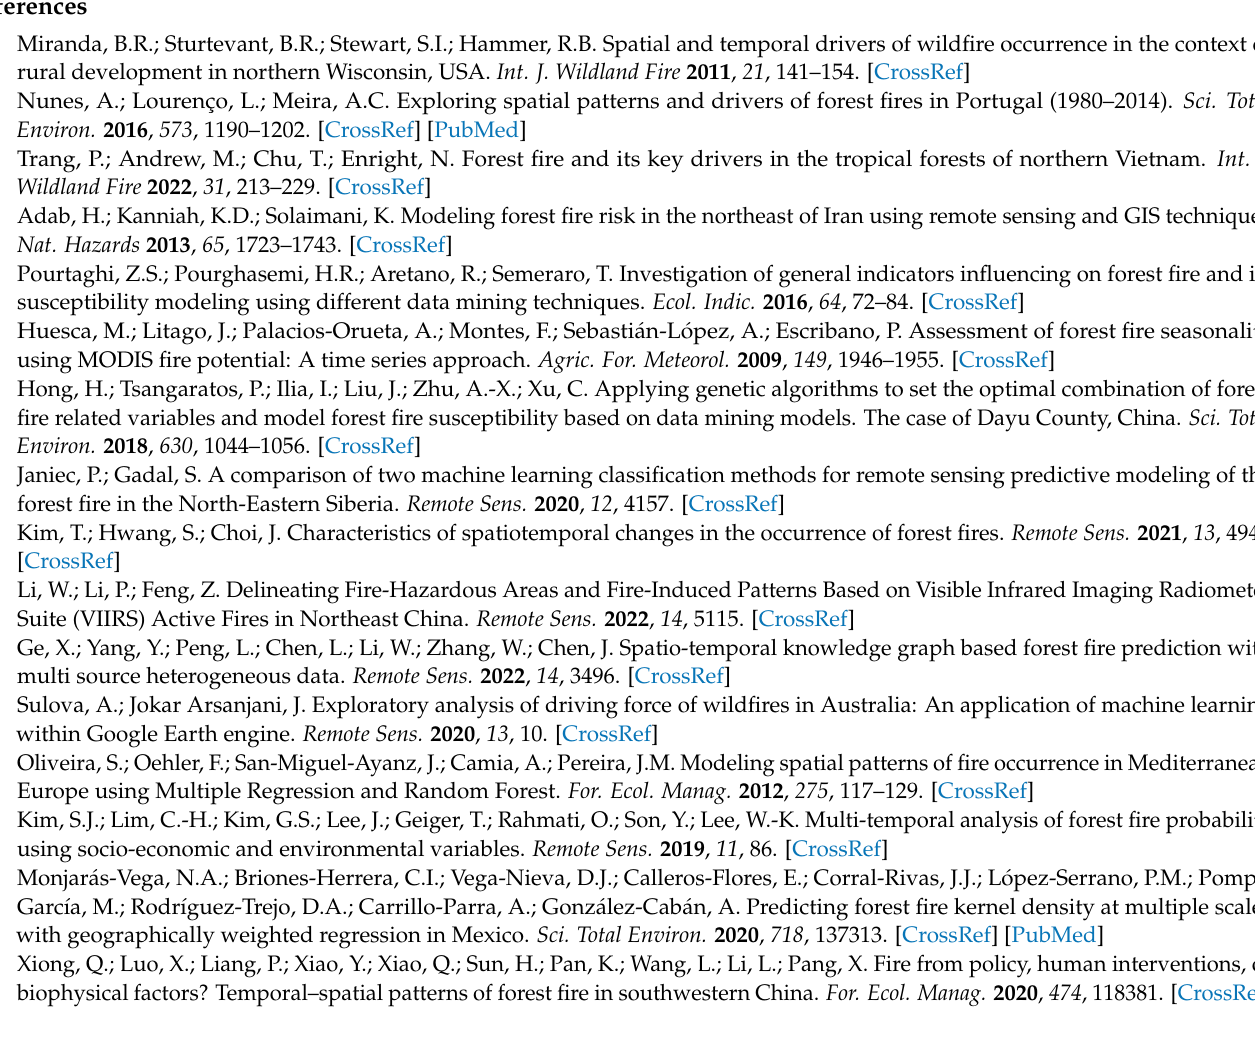
Figure S6: Spatial distribution of PREP coefficients for Anhui province from 2012 to 2020, Figure S7: Spatial distribution of Tmax coefficients for Anhui province from 2012 to 2020, Figure S8: Spatial distribution of Tmin coefficients for Anhui province from 2012 to 2020, Figure S9: Spatial distribution of ELE coefficients for Anhui province from 2012 to 2020, Figure S10: Spatial distribution of SAG coefficients for Anhui province from 2012 to